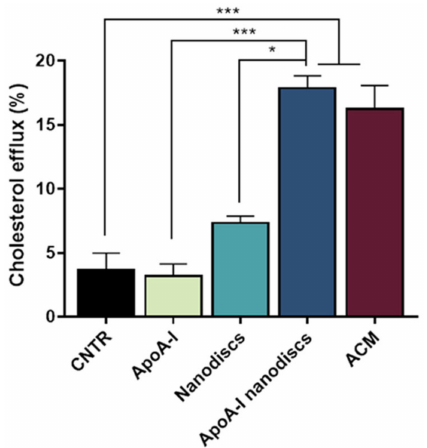
Figure 8. Evaluation of the ability of apoA-1 nanodiscs as cholesterol acceptors. The cholesterol efflux was measured using the Cholesterol Efflux Assay kit. NHA cells were treated with different cholesterol acceptors: free apoA-I, nanodiscs, apoA-I nanodiscs, and ACM. The fluorescence of supernatant and of cell lysates was measured by spectrofluorometer; * p < 0.05; *** p < 0.001 (one-way